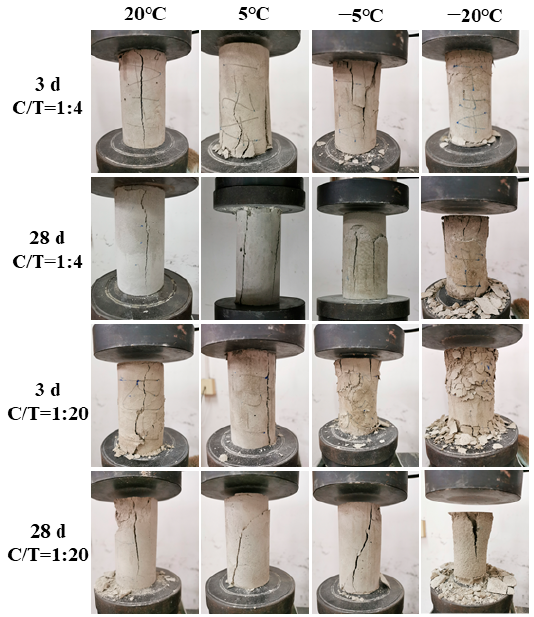
Figure 7. Failure photographs of CTB specimens at different curing times. (CTR of 1:4 and 1:20, curing temperatures are 20, 5, − 5, and − 20 °C).